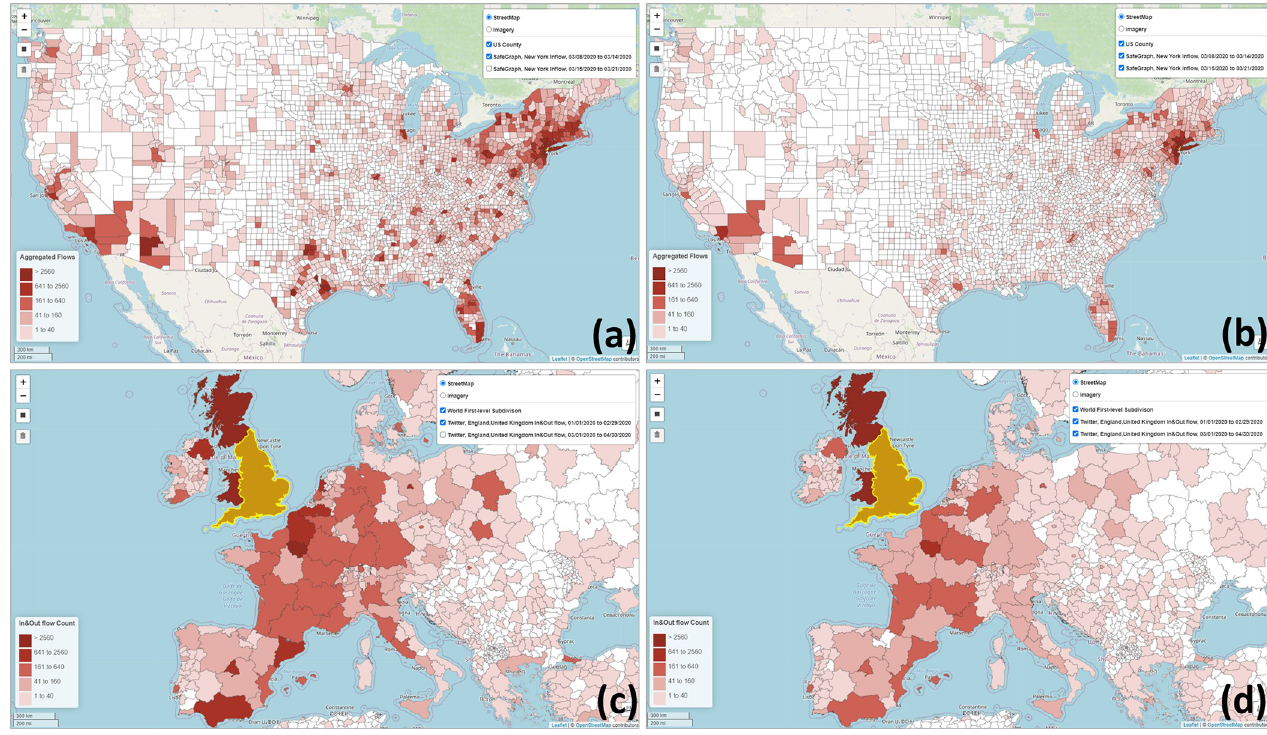
Fig 5. SafeGraph-derived county population flows to New York County from (a) 03/08/2020 to 03/14/2020 and (b) for the following week (03/15/2020 to 03/ 21/2020). Twitter-derived in & out flows between England, UK and other first-level administrative units in the Europe area for (c) 01/01/2020 to 02/29/2020, and (d) 03/01/2020 to 04/30/2020.